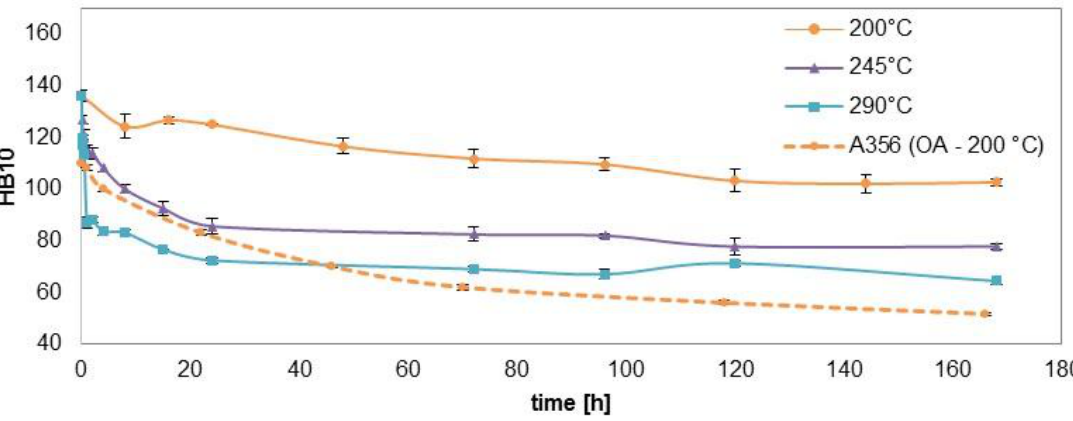
Figure 10. Over aging curves of the A354-T6* alloy carried out at 200, 245, and 290 °C. For comparison, the curve of A356-T6 alloy overaged at 200 °C is also presented. The data is from Reference [21].